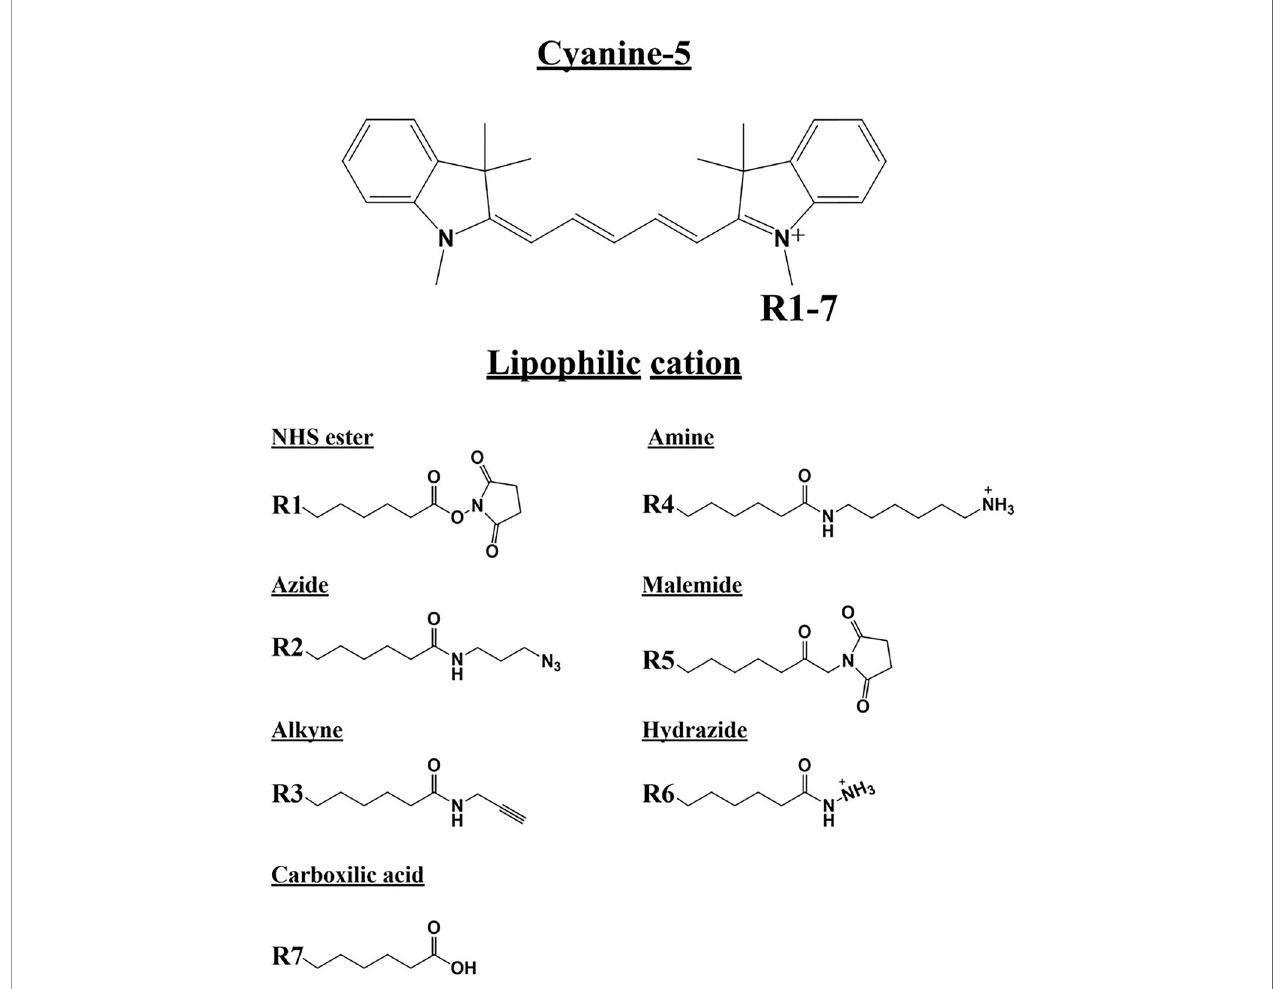
FIGURE 10 | Cyanine 5 structure and analogue structures. Upper: The chemical structure of cyanine 5 compounds is characterized by a polymethine bridge in between the two nitrogen atoms. The positive charge (+) is delocalized within the scaffold on one of the two amine groups (N+). The amine group can be used to attach several different side chains (R1-7). Lower: Below are different Cyanine 5 analogue with their side chain structure